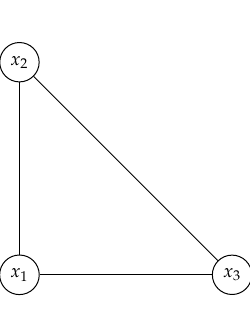
Figure 1. A triangle